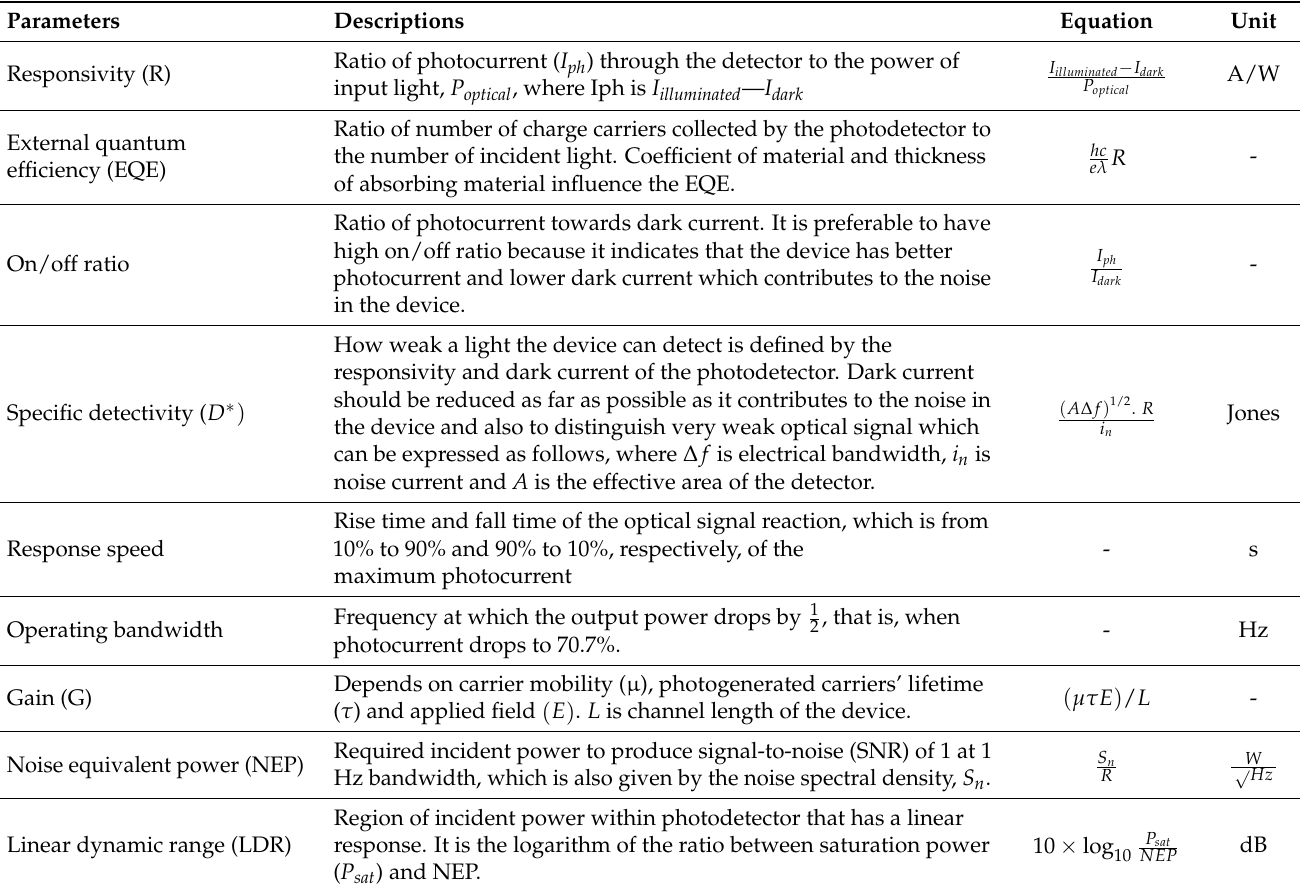
Table 1. Key performance parameters of